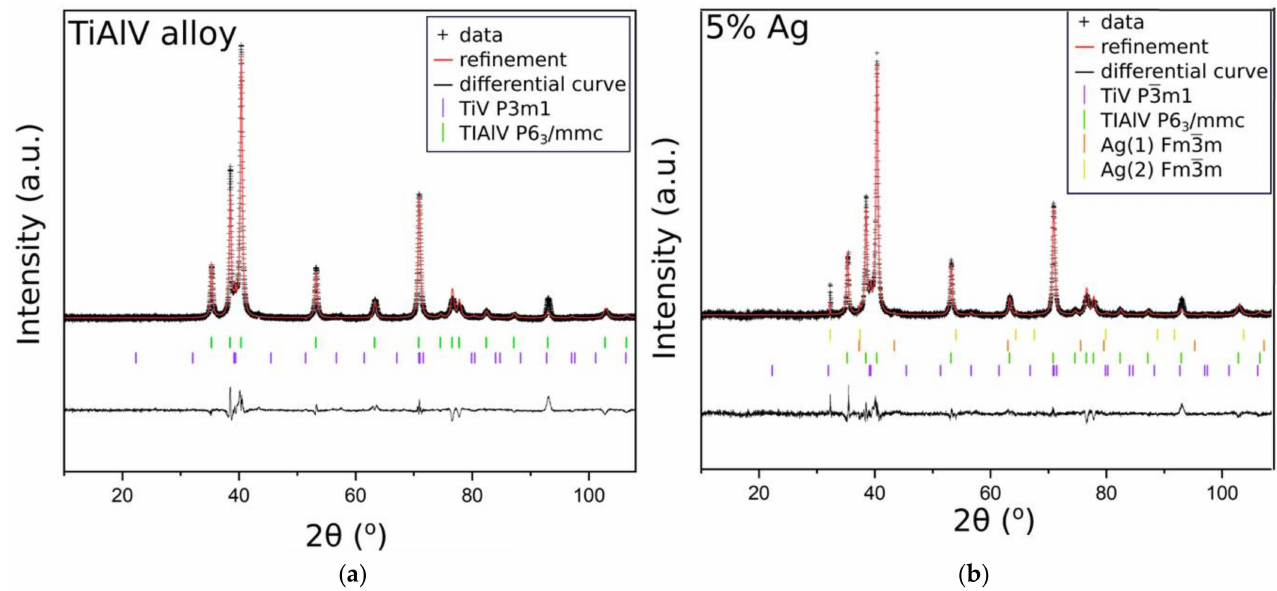
Figure 4. XRD patterns of the TiAlV alloy ( a ); the TiAlV alloy with 5% silver nanoparticles in the SiO 2 matrix ( b